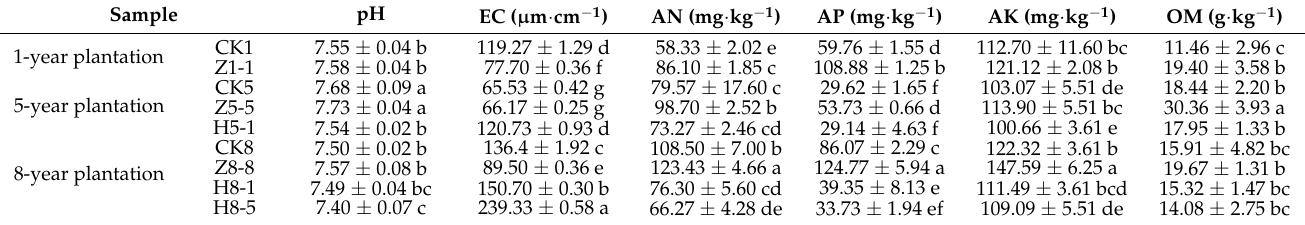
Table 2. Physical and chemical properties of cultivated soil in different planting and replanting